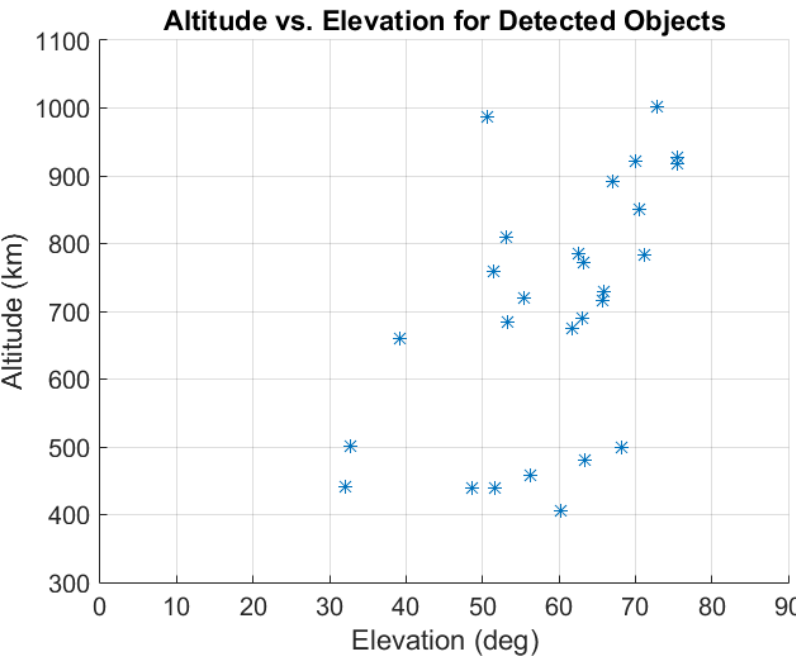
Figure 7. Scatter plot of altitude vs. elevation for the detected objects.